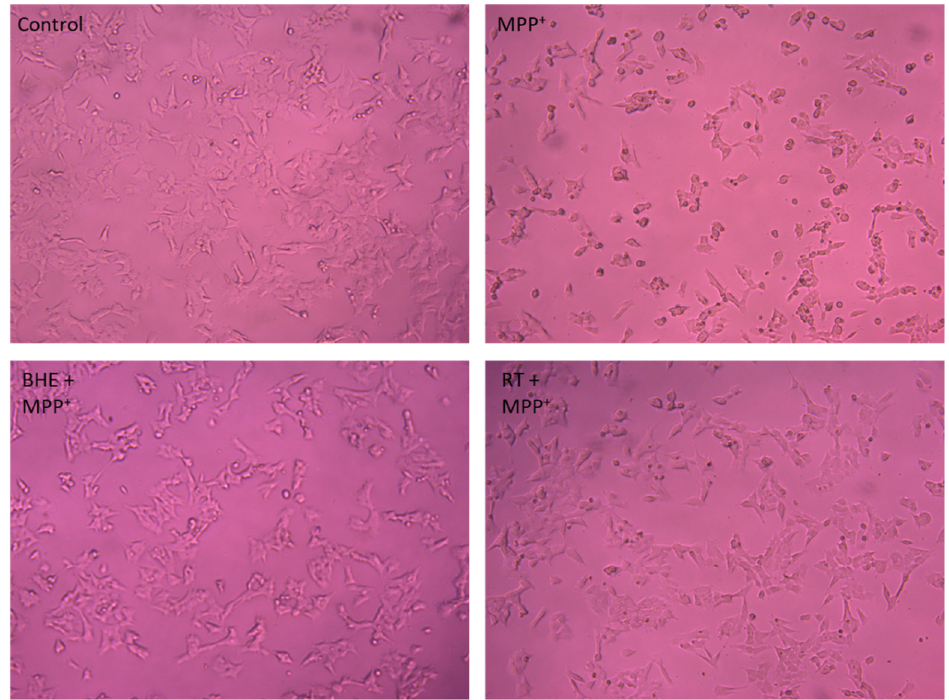
Figure 7. BHE and compounds inhibit SH-SY5Y morphological changes induced by MPP + . SH-SY5Y cells were pre-treated with BHE and compounds (2.5 µg/mL) before exposure to 2000 µM MPP + for 24 h. Cells were visualized, and images acquired using the light microscope at 100× magnification.